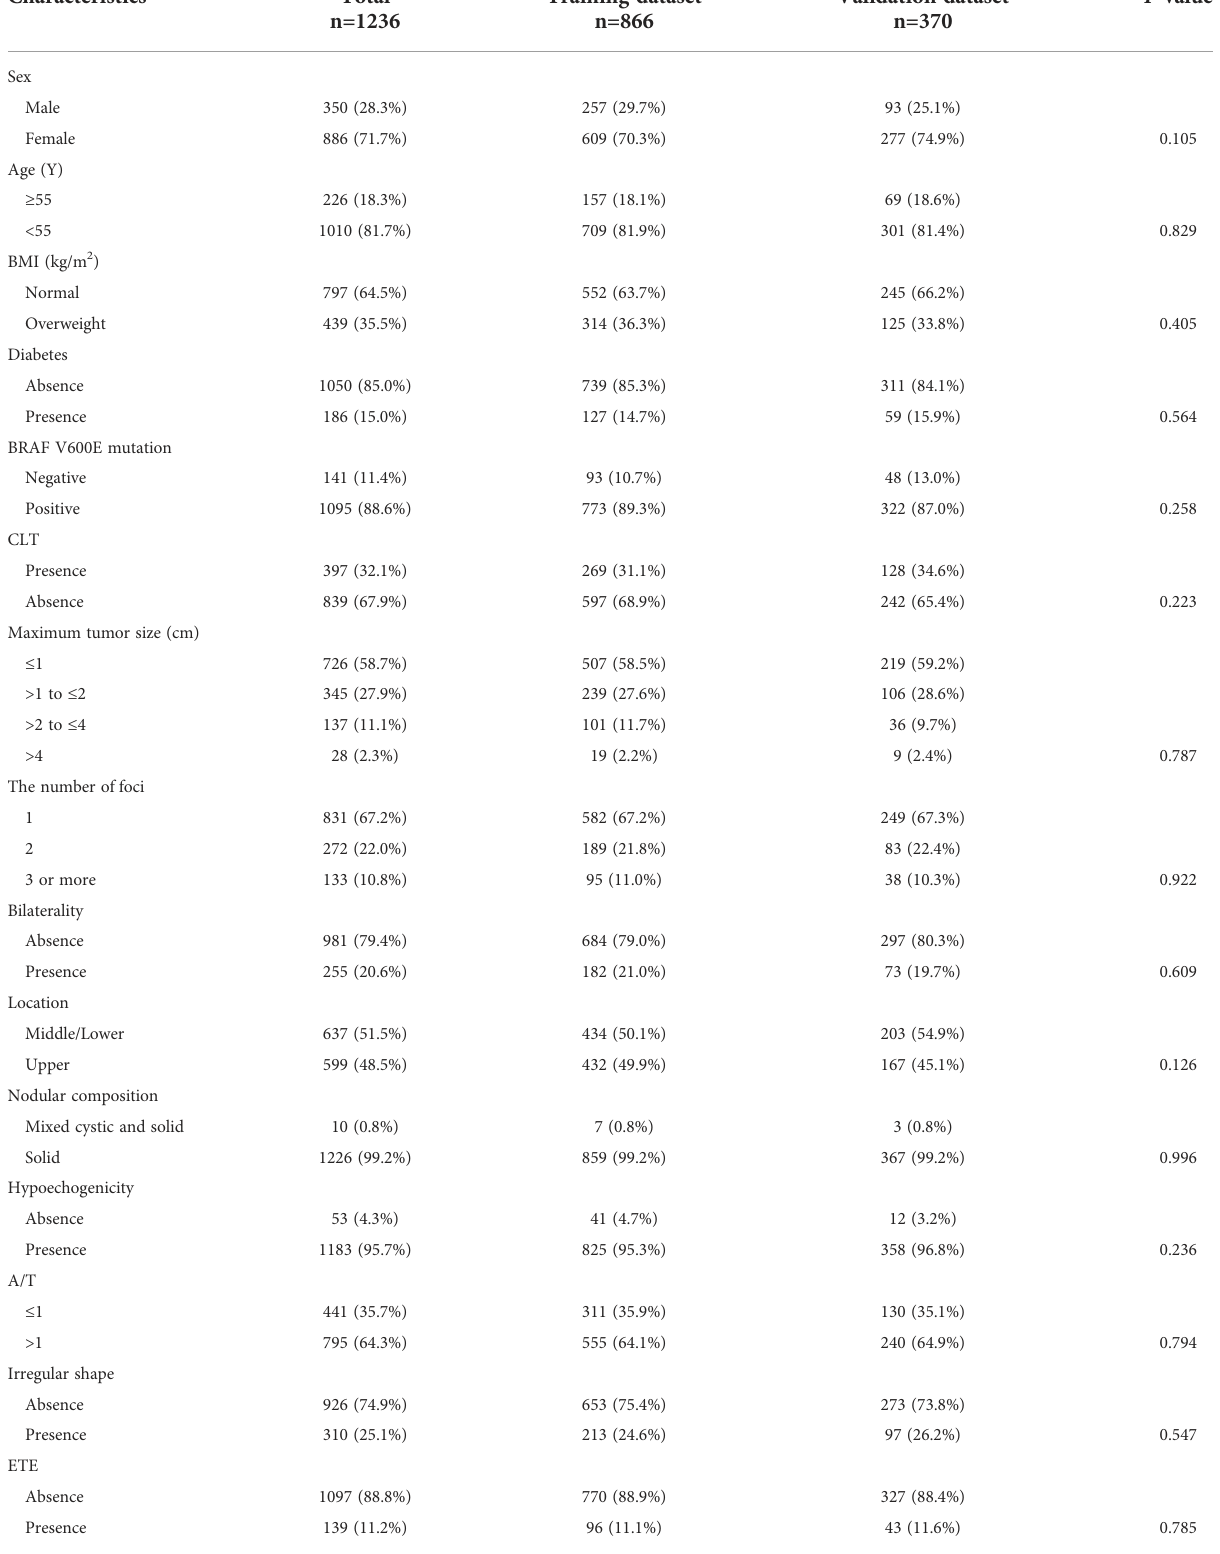
TABLE 1 Comparison of clinical and ultrasonic characteristics of the PTC patients in the training and validation